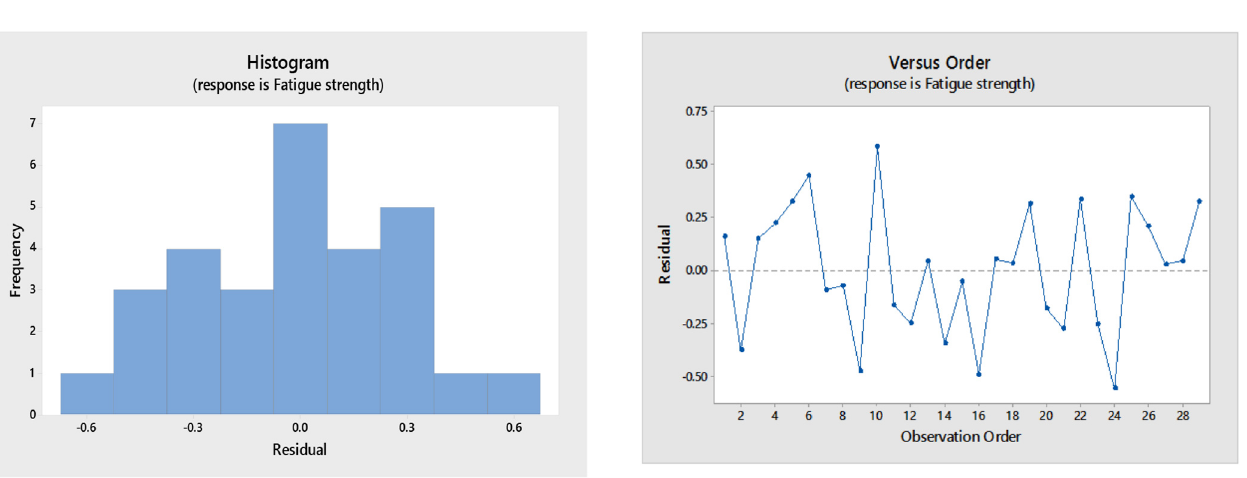
Fig. 8. Histogram of residuals.